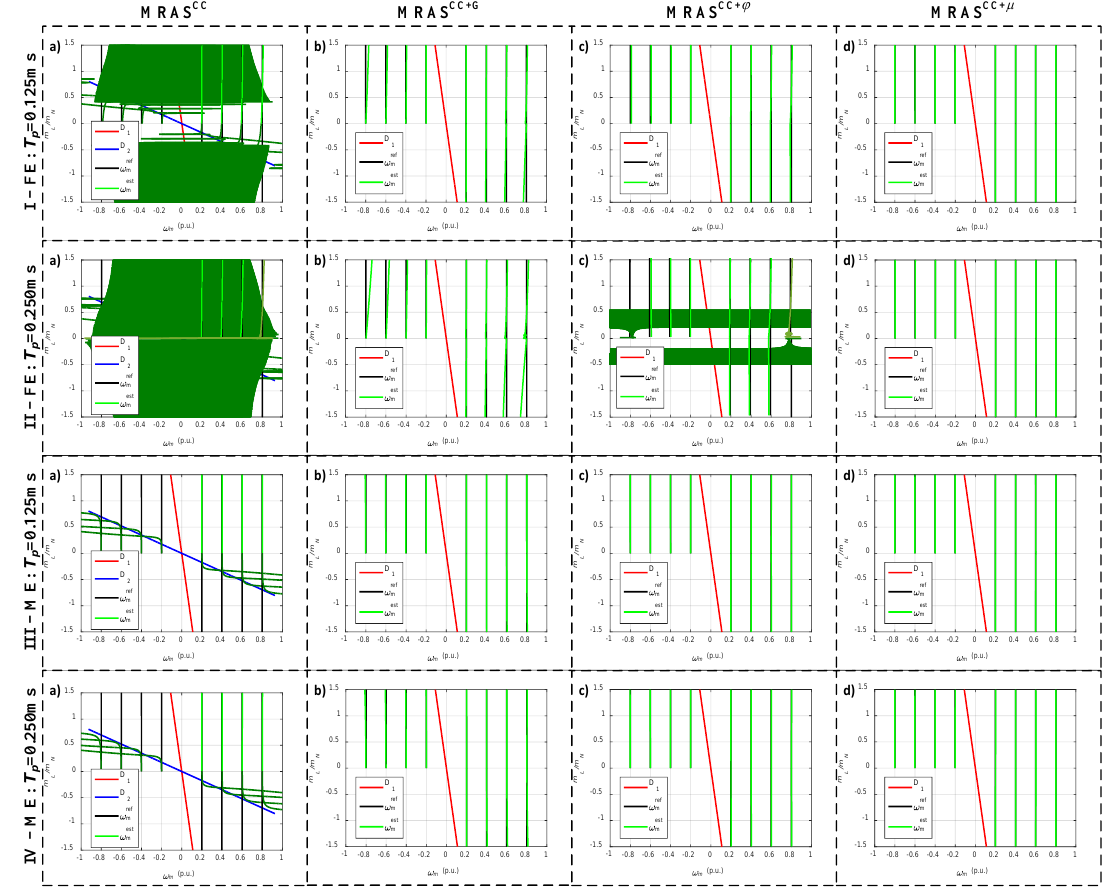
Figure 10. Speed-torque graphs ( ω m -m L ) for four tested MRAS CC -type estimators: classical MRAS CC —column ( a ), MRAS CC+ G —column ( b ), MRAS CC+ ϕ —column ( c ), MRAS CC+ µ —column ( d ) for two sampling times: T s = 0.125 ms (row I, III), T s = 0.250 ms (row II, IV) and numerical methods: FE (row I, II), ME (row III, IV)—simulation results. (Straight light green lines—the system is stable, dark green lines—the system is unstable).